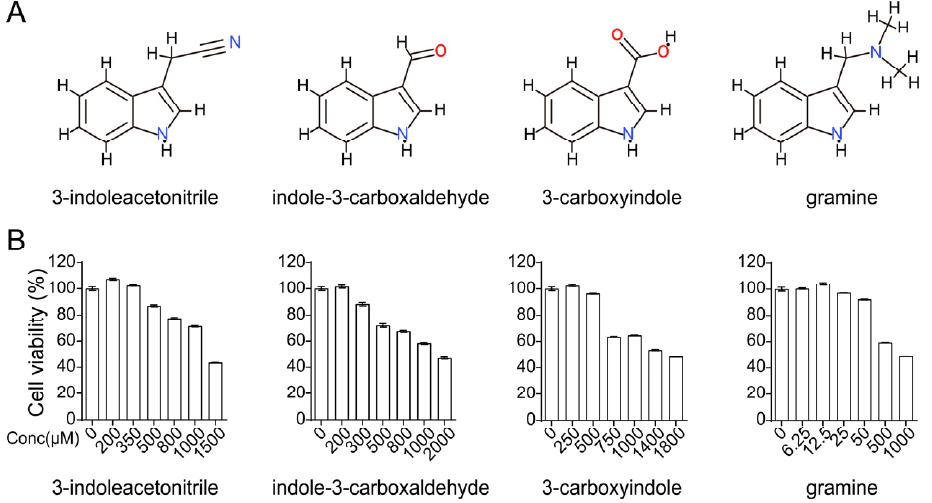
Figure 1. Cytotoxicity of indole derivatives in A549 cells. ( A ) Molecular structure of 3-indoleacetonitrile, indole-3-carboxaldehyde, 3-carboxyindole, and gramine. ( B ) A549 cells were treated with 3-indoleacetonitrile, indole-3-carboxaldehyde, 3-carboxyindole, or gramine using the indicated concen- trations for 24 h. Then, the cell viability was measured by